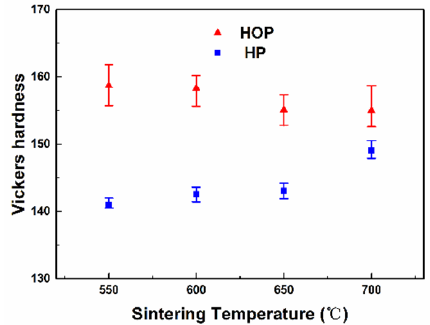
Figure 4. Microstructure of sample prepared by HOP at 550 °C. ( a ) SEM and ( b ) EBSD images show- ing microstructure. ( c ) SEM image of over–etched sample showing distribution of CNTs. ( d ) TEM image of a CNT in the Cu matrix.